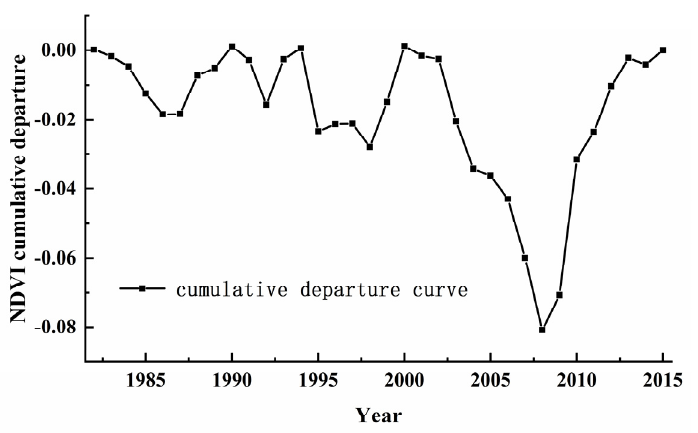
Figure 8. NDVI cumulative departure.